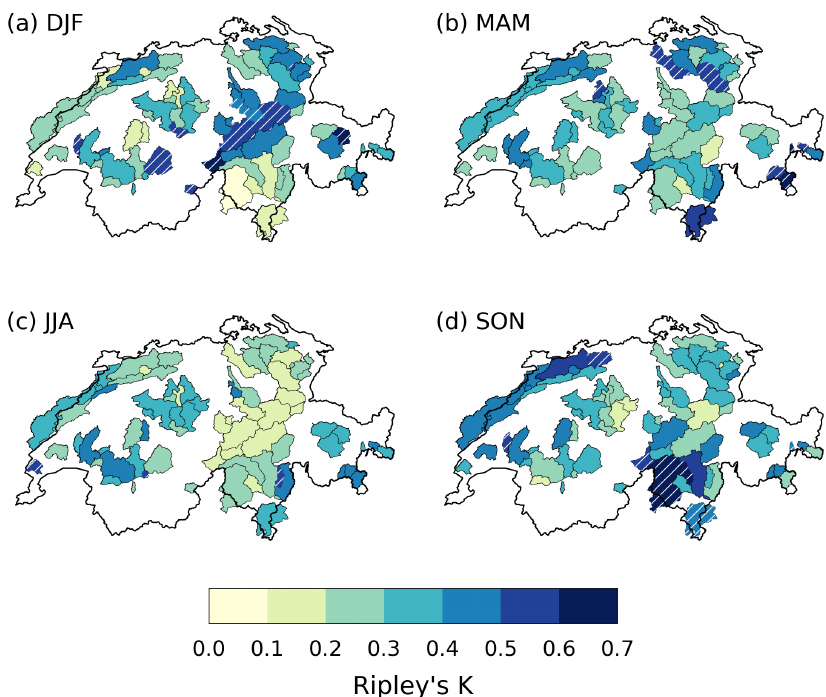
Figure A4. Value of Ripley’s K in the RhiresD dataset for a 20d window, in (a) DJF, (b) MAM, (c) JJA and (d) SON, for the 63-catchment partition. Compare with Fig. 4.